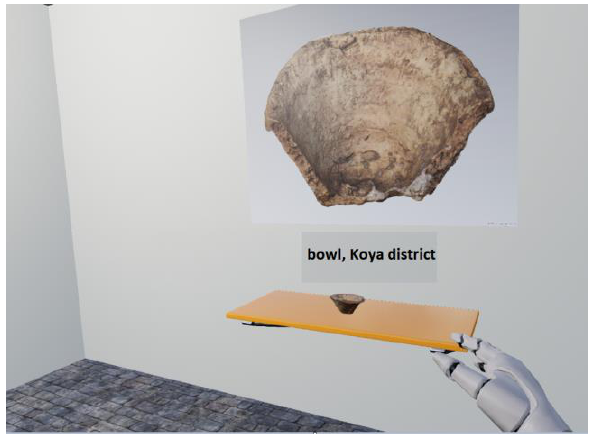
Figure 18. model placed in VR museum